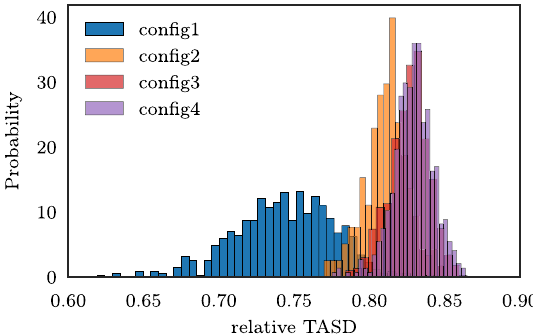
FIG. 8. Distribution of the relative time average spectral density of γ -ray for the various simulated ordering configuration 1, 2, 3, and